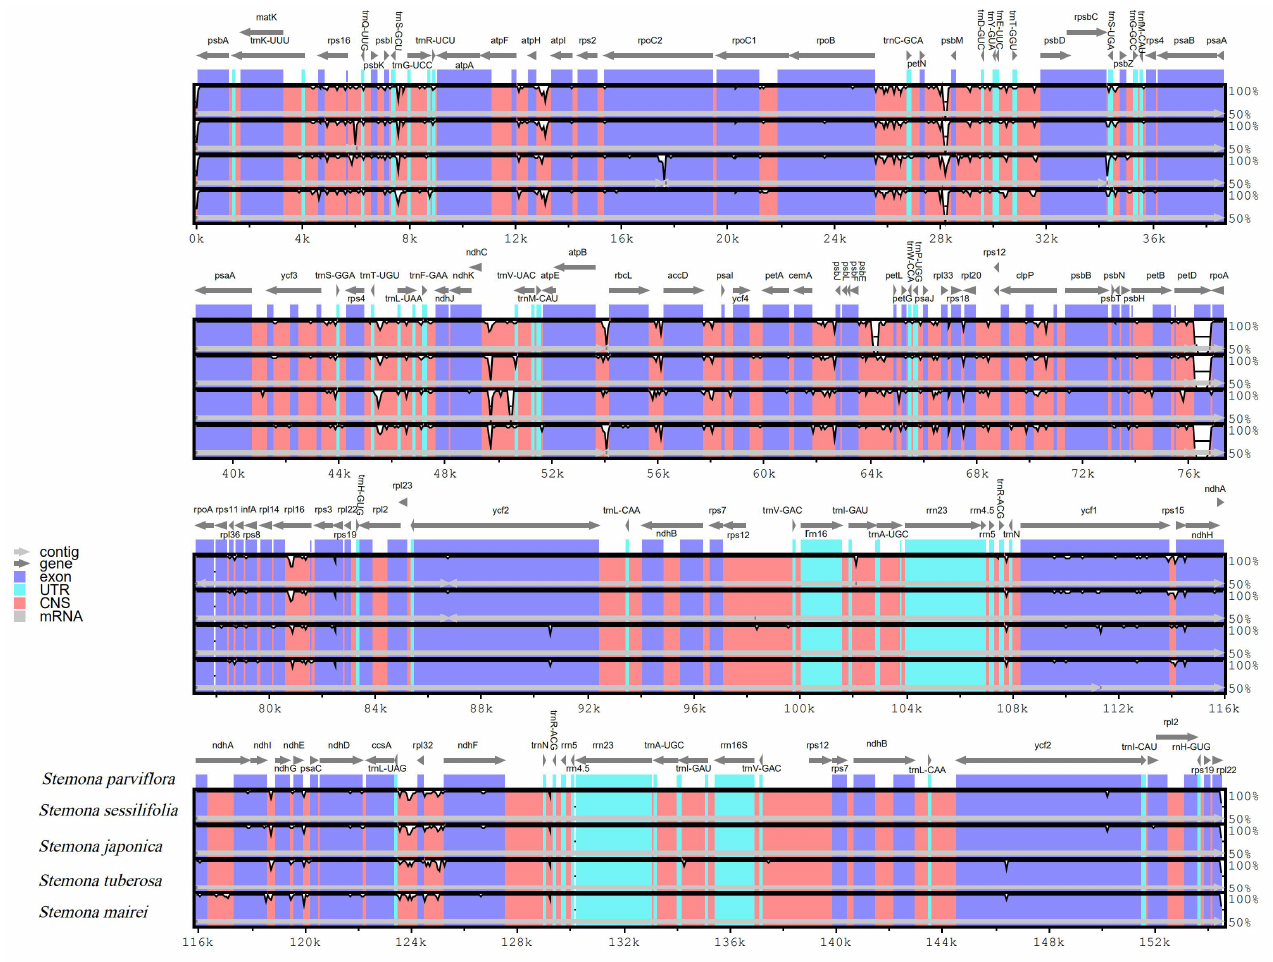
Figure 3. Comparison of Stemona chloroplast genomes using mVISTA, with S. parviflora chloroplast genome as reference.